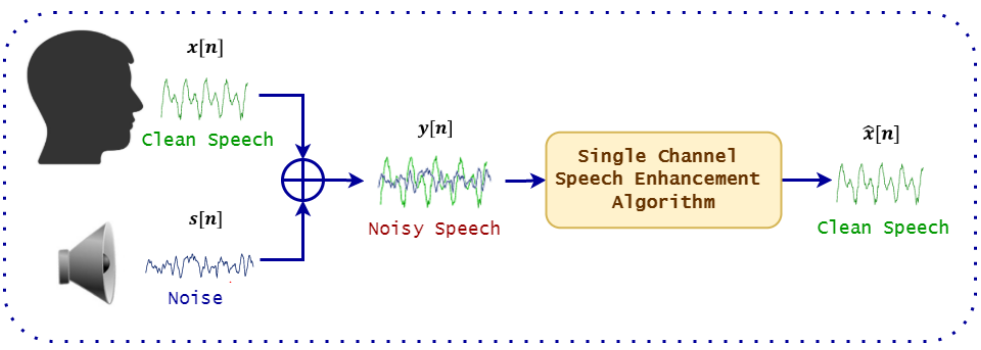
Figure 1. The basic diagram of speech enhancement